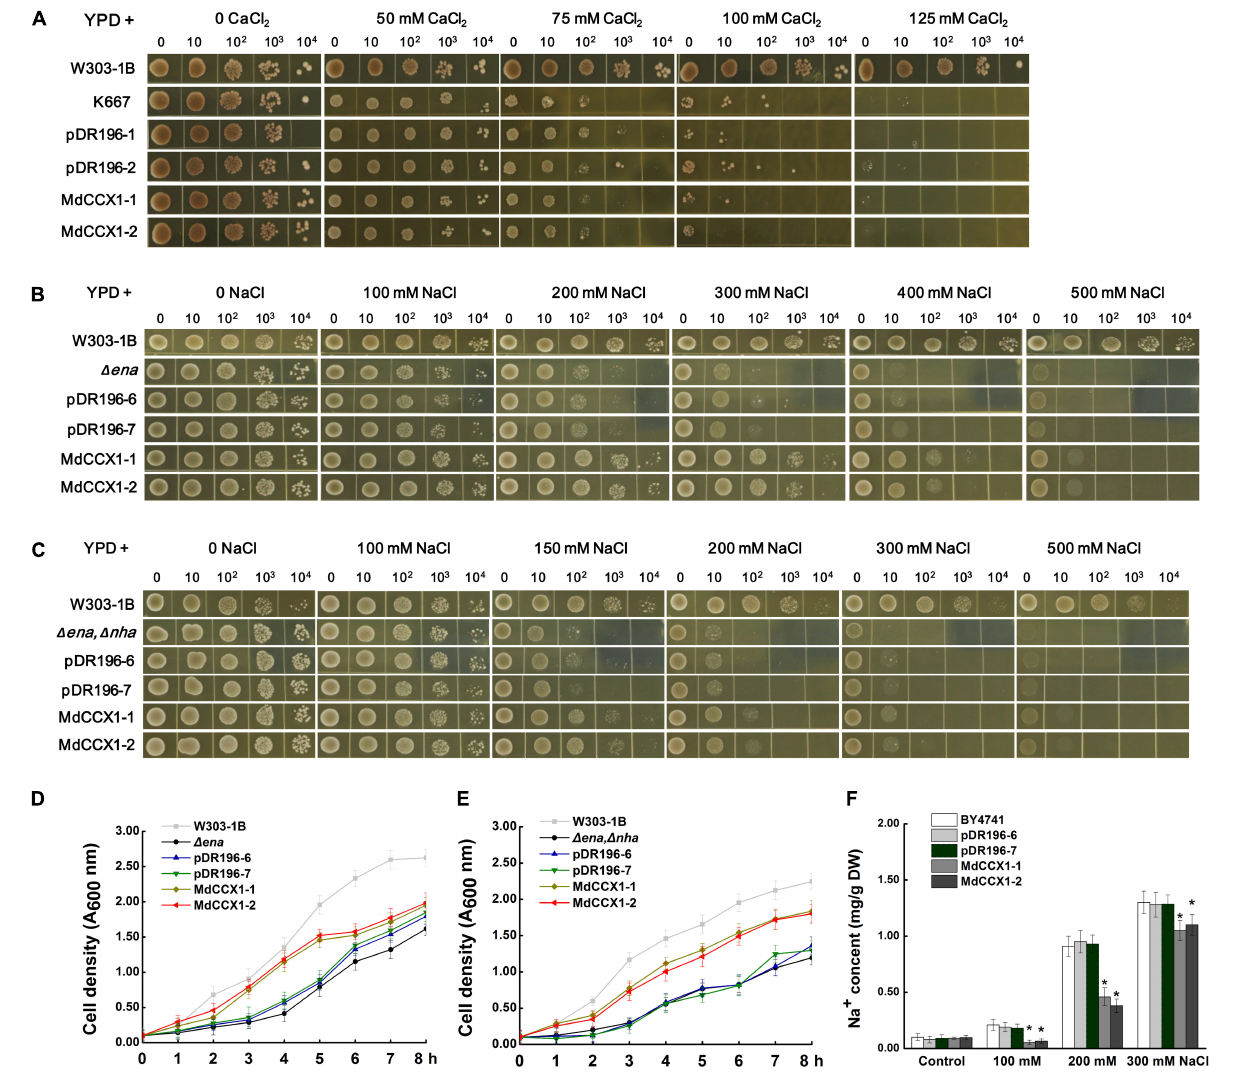
FIGURE 3 | Functional complementarity experiments of MdCCX1 in yeast mutants. (A) Identification of Ca 2 + transport characteristics of MdCCX1 in K667. The K667 yeast triple mutant ( (cid:49) pmc1 (cid:49) vcx1 (cid:49) cnb1) was transformed with the pDR196 empty vector or pDR196- MdCCX1 . 10- µ l aliquots of serial dilutions (10, 10 2 , 10 3 , and 10 4 ) were dotted onto YPD medium in the presence of 0, 50, 75, 100, 125 mM CaCl 2 and grown for 3 d. W303-1B was the positive control. (B) and (C) Na + tolerance of yeast cells expressing pDR196- MdCCX1 or pDR196 in (cid:49) ena1-4 (B) or (cid:49) ena1-4 , (cid:49) nha1 (C) yeast mutants. After gradient dilution of the positive transformants and the control yeast lines, 10- µ l aliquots of serial dilutions (10, 10 2 , 10 3 , and 10 4 ) were dotted onto YPD medium supplemented with different concentrations of NaCl and grown for 3 d. (D) and (E) Growth curves of yeast strains in (C) and (D) under 200 mM NaCl treatment with an initial concentration of OD 600 = 0.1. (F) Sodium content in yeast cells. The wild-type yeast BY4741 was transformed with pDR196- MdCCX1 or pDR196. All yeast strains grown in YPD medium supplemented with 0, 100, 200, or 300 mM NaCl to the logarithmic growth phase were collected for Na + determination. Data are average values of three independent experiments and are presented as mean ± SD. Significant differences (*) relative to the empty vector and BY4741 were determined using Student’s t-test : p <